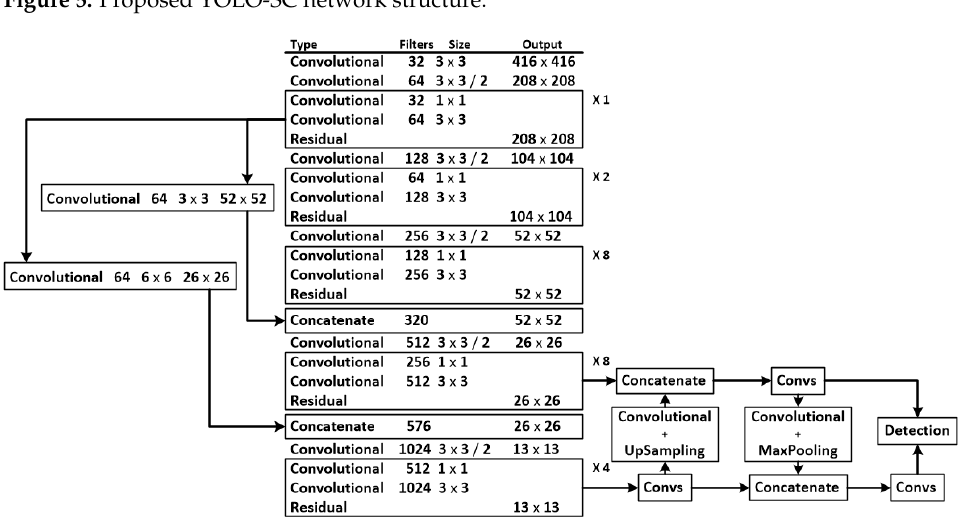
Figure 6. YOLO-SC network